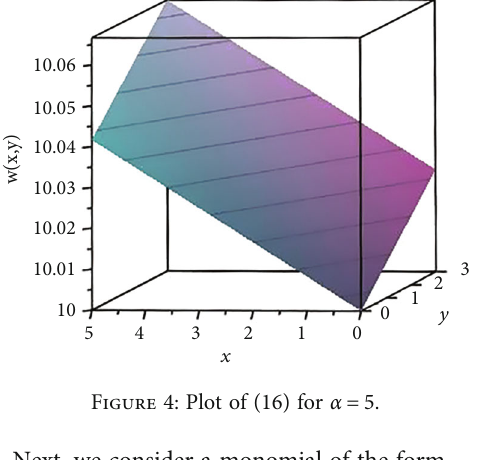
Figure 4: Plot of (16) for α = 5 .